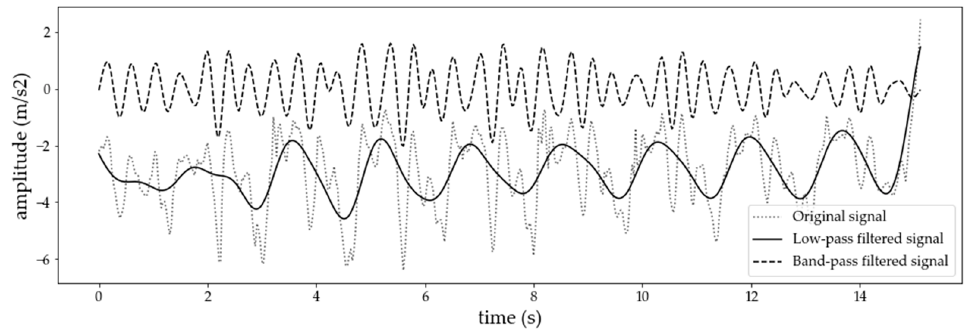
Figure 4. An example of an original and filtered (low-pass and band-pass) 15-s accelerometer x-axis signal.